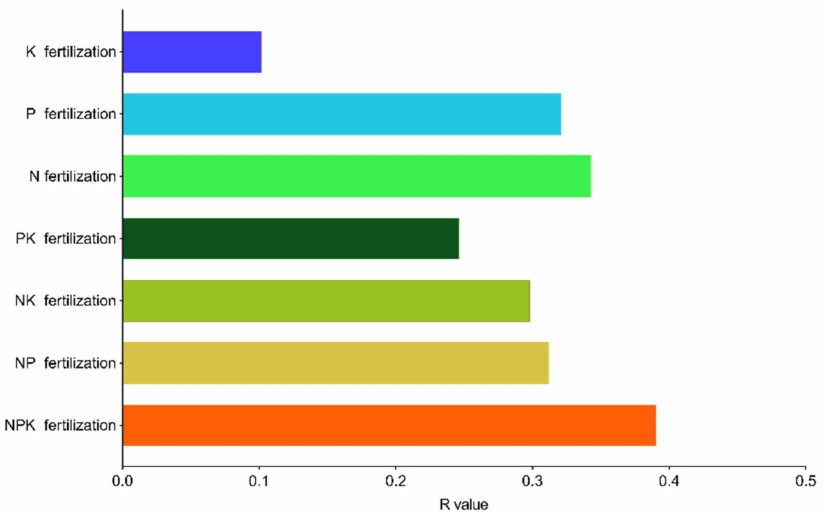
Figure 2. Anosim significance test of community structure difference between Phoebe bournei seedlings’ different fertilization groups. R-value ranges between − 1 and 1 (values >0 indicate a significant difference between